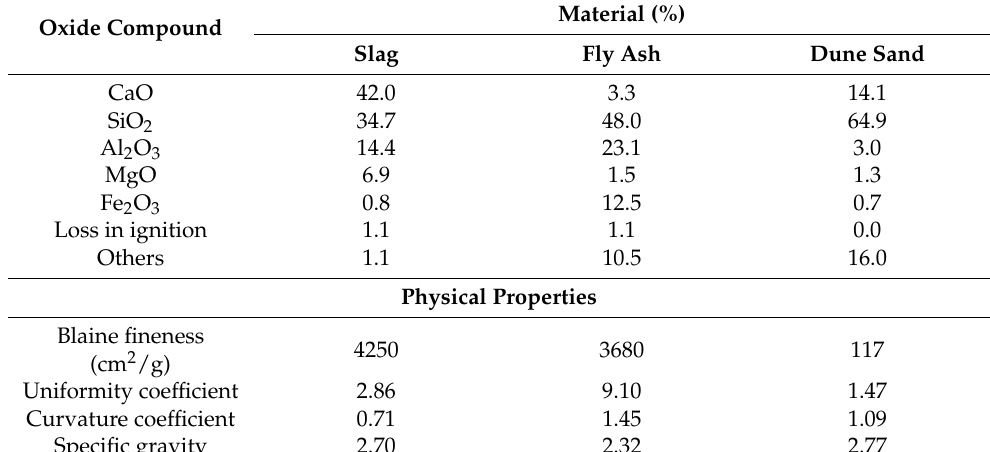
Table 1. Chemical composition and physical properties of the as-received materials. Oxide Compound